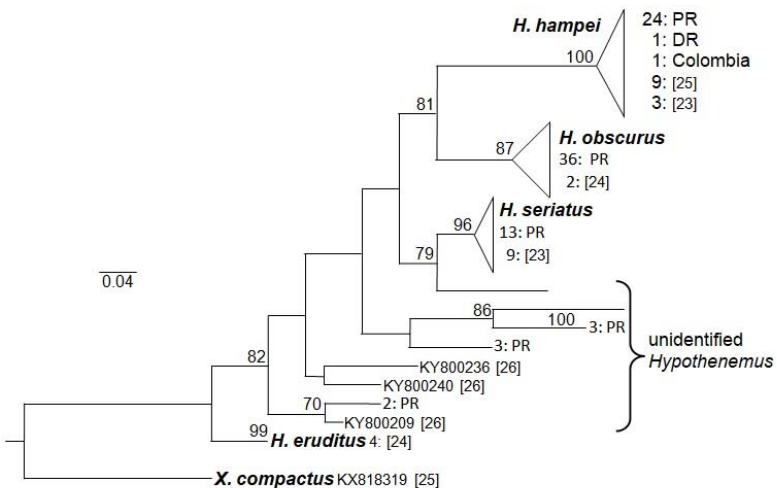
Figure2. Maximum-likelihoodtreeof Hypothenemus . Numbersatnodesshowbootstrapvaluesover50%. Numbers of individuals per clade and source is shown at the right. Individuals used for DNA barcoding were a subset of those identified by morphology. Sources of additional sequences: [25] Mitchell and Maddox 2010; [23] Gautier 2010; [26] Kambestad et al. 2017. GeneBank accession number for sequences generated in this study: H. hampei : (MK622703 to MK622727); H. obscurus (MK622728 to MK622760 and MK622773 to MK622775); H. seriatus (MK622761 to MK622772), Hypothenemus sp. (MK622776 to